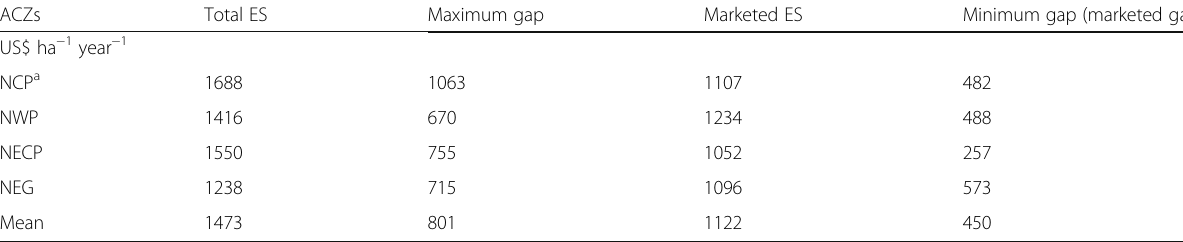
Table 5 Comparison of economic gap between total and marketed